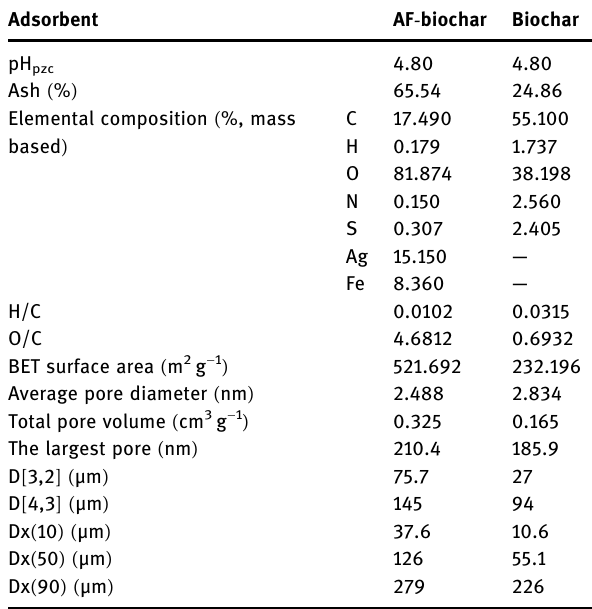
Table 1: Physicochemical properties of AF - biochar and biochar